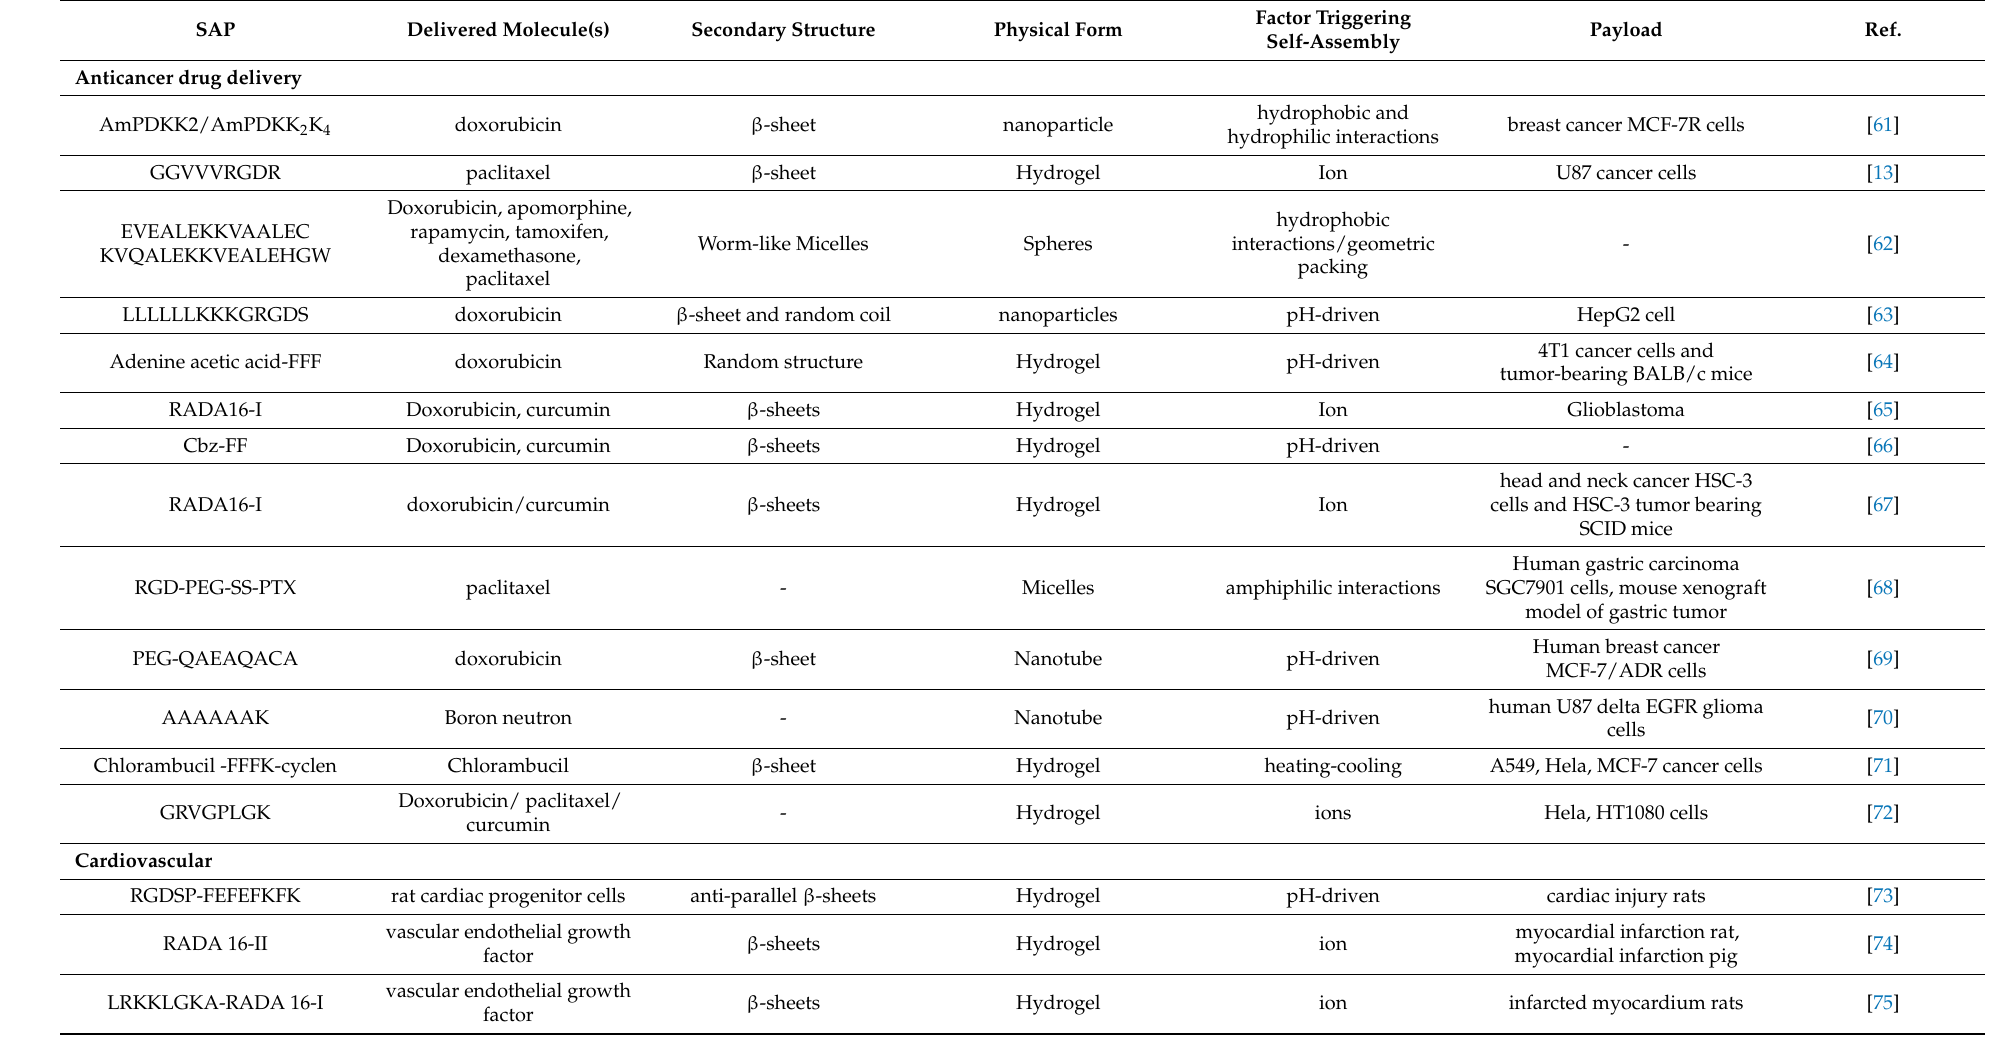
Table 1. Applications of SAP-based delivery